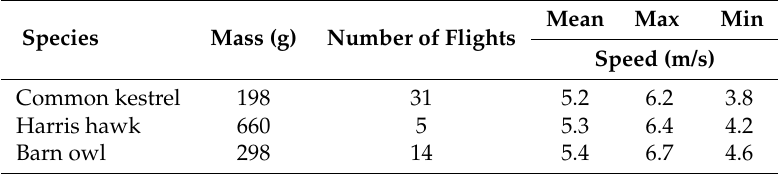
Table 1. Summary of the flight noise test conducted by Sarradj et al.